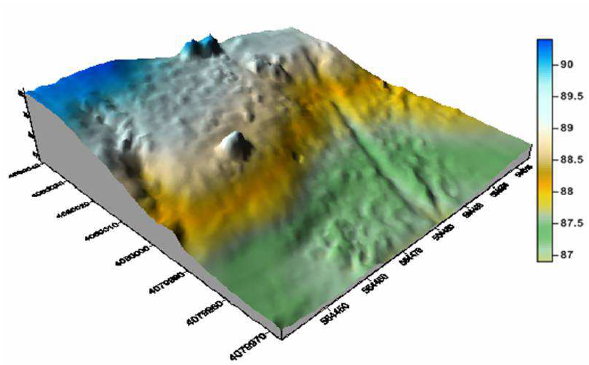
Figure 5. DEM interpolated with a 10 cm grid using the radial basis function method